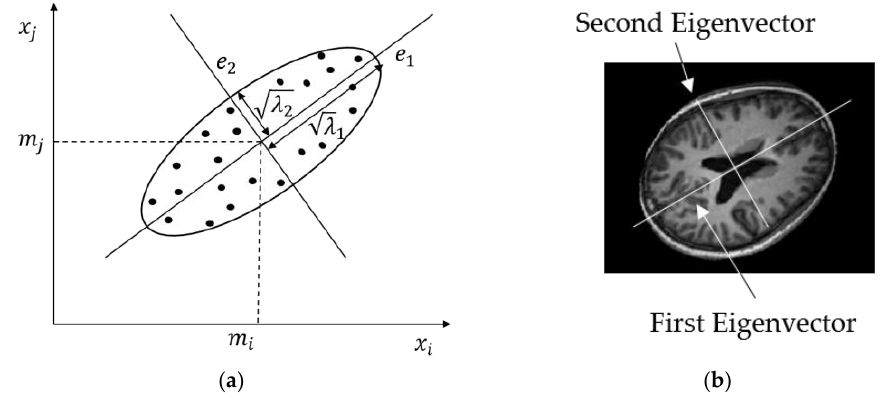
Figure 5. Estimation of symmetry axis orientation θ r . First column: input images; second column: alignment of the brain bilateral symmetry axis with the vertical axis of the image using θ 1 ; last column: brain bilateral symmetry axis alignment using θ r = θ 1 + θ 2 . Note that θ 2 = 0 in the first row.